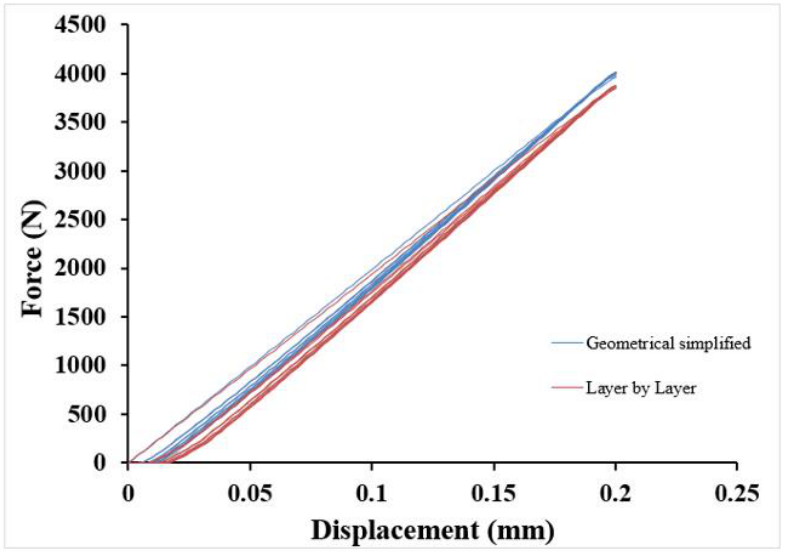
Figure 12. Compression force–displacement diagram and comparison between numerical simulation results of the layered and simplified geometrical models.